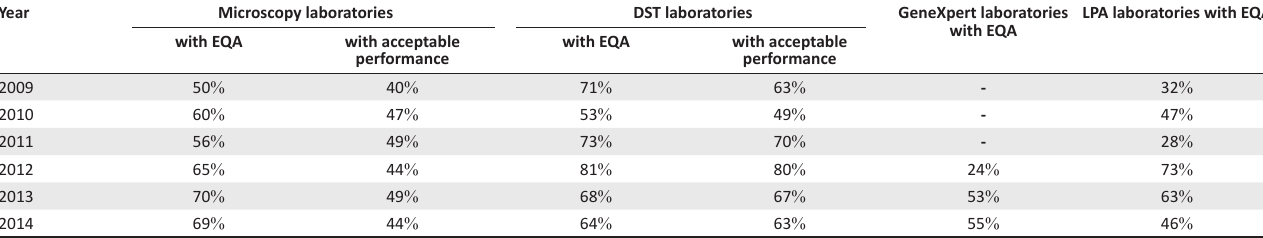
FIGURE 2: Tuberculosis drug susceptibility testing. First- and second-line tuberculosis drug susceptibility tests performed for notified cases reported in 2015 in TABLE 5: Quality of tuberculosis laboratory services in Africa, 2009–2014.